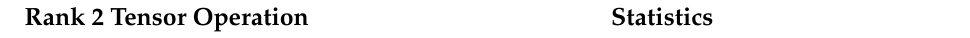
Table 11. Raspberry Pi III B+ benchmark statistics for rank 2 tensor operations with k = 32 (times in